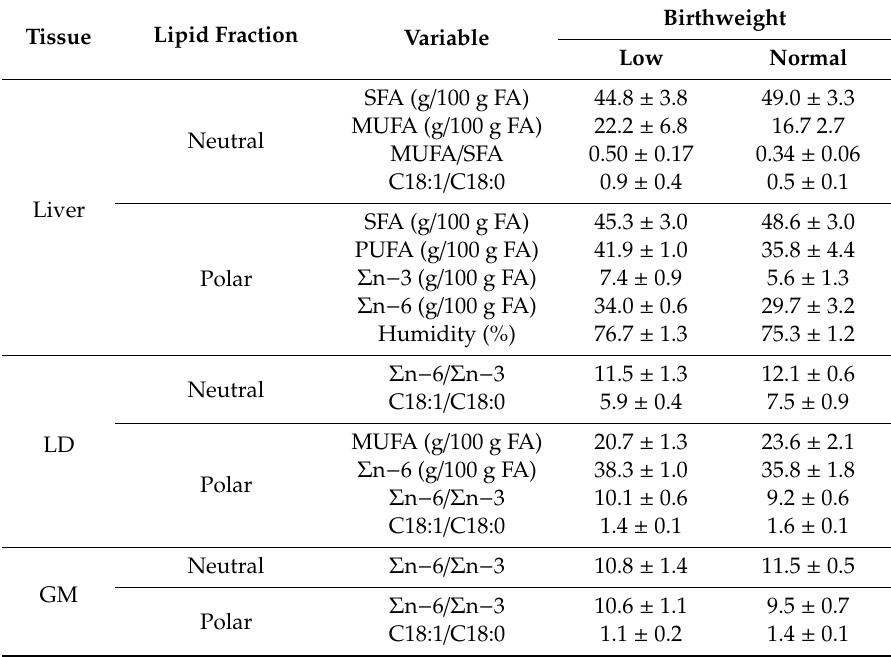
Table 4. Highlighted significant di ff erences ( p < 0.05) in the fatty acid (FA) composition of di ff erent tissues between piglets with normal or low birthweight at 25 days